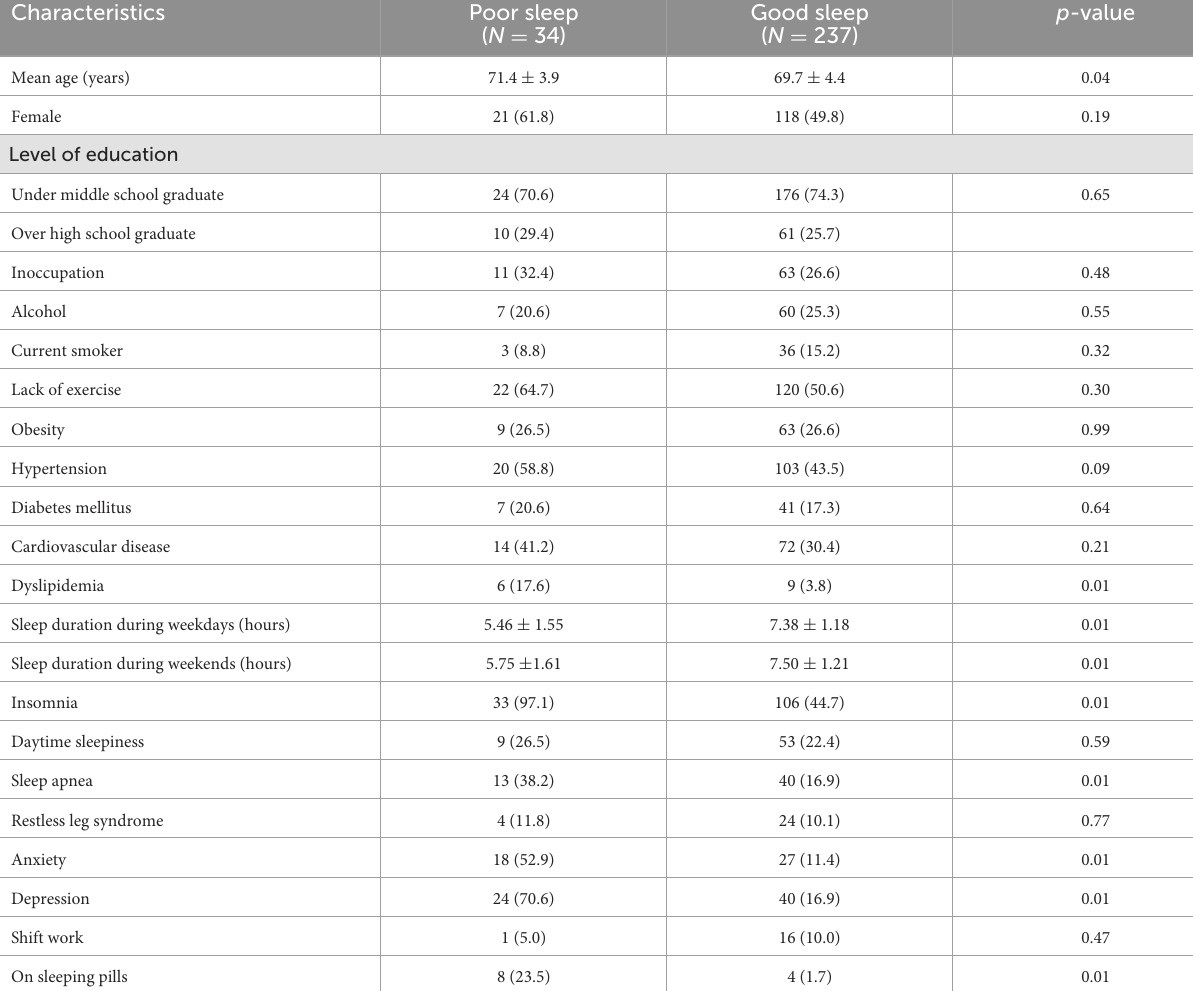
TABLE 2 Comparison between elderly individuals with good and poor sleep quality.